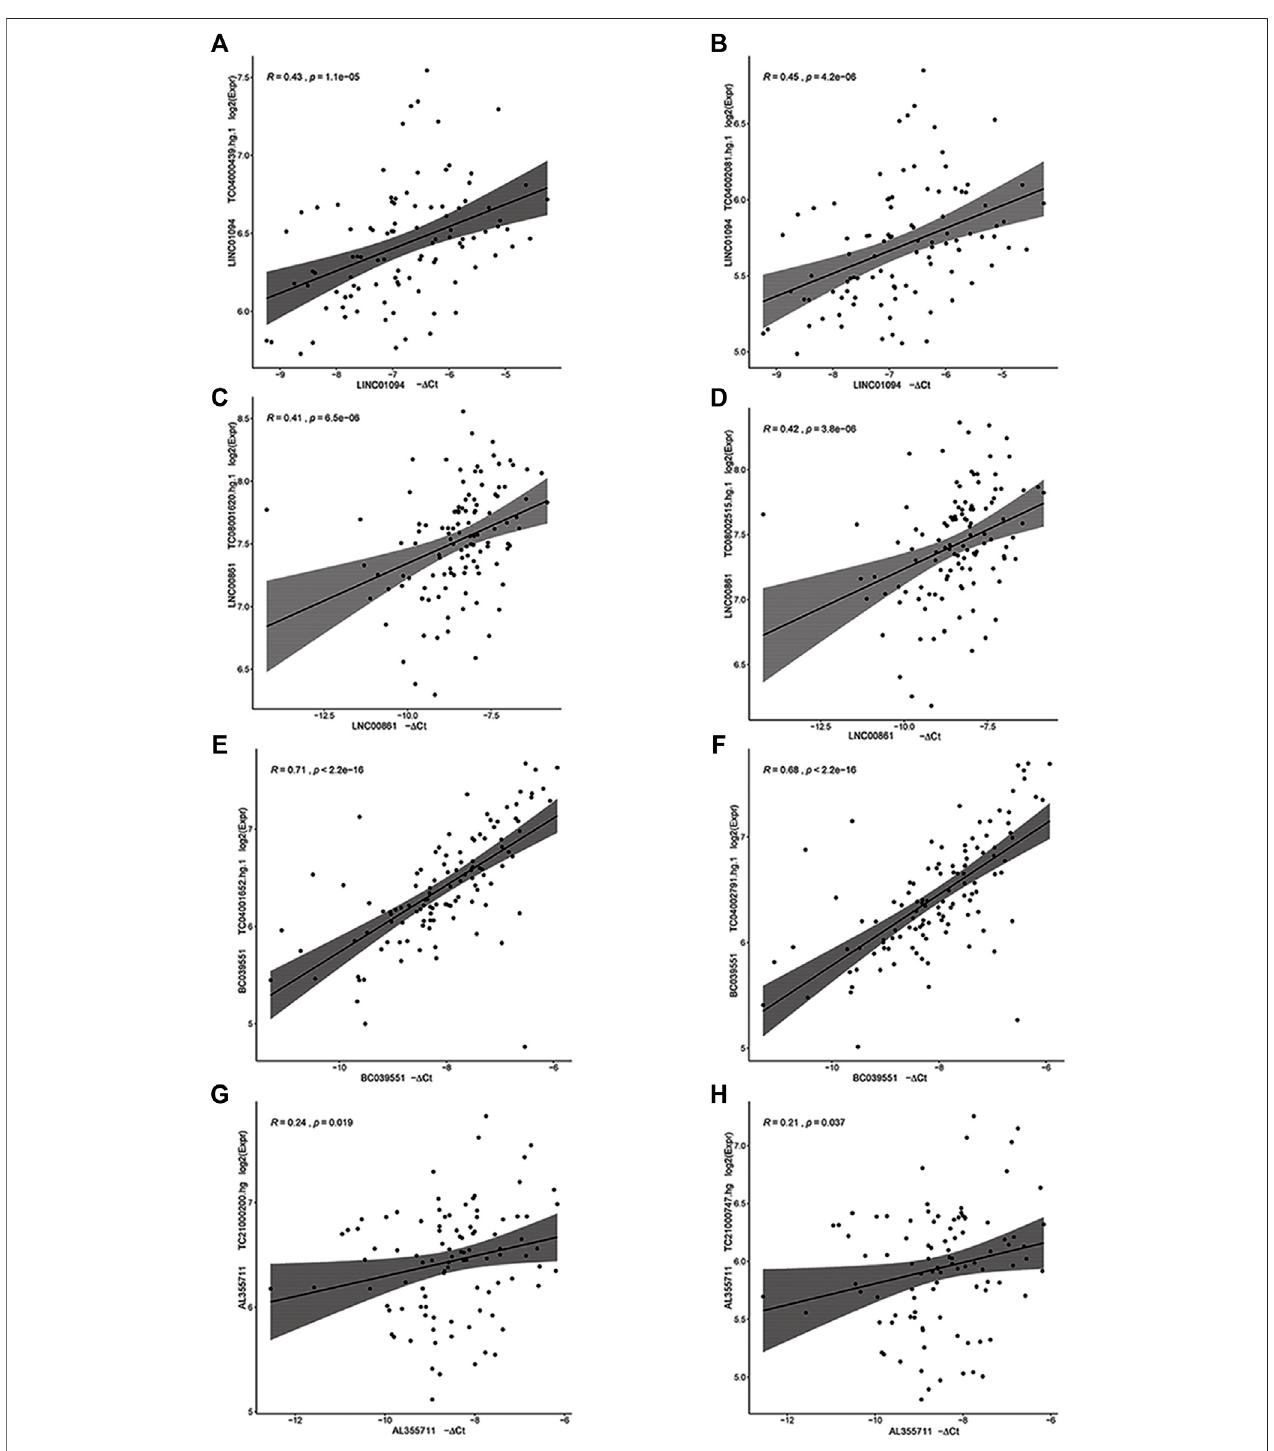
FIGURE 2 | Correlation between microarray (Y-axis) and RT-qPCR (X-axis) log2 gene expression for four lncRNA genes. A linear model fi t and 95% con fi dence intervals of the mean are also shown. (A,B) LINC01094 , (C,D) LINC00861 , (E,F) BC039551 , (G,H) AL355711.